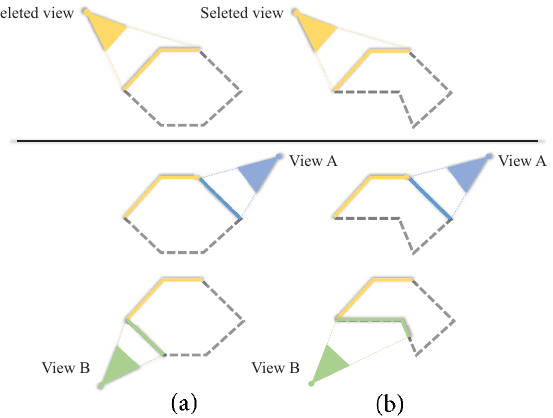
Fig. 13 Reducing ambiguity. Given hypotheses (a) and (b), view A cannot provide useful information, but view B can provide new information to verify which hypothesis is correct. Reproduced with permission from Ref. [77], c (cid:2) IEEE